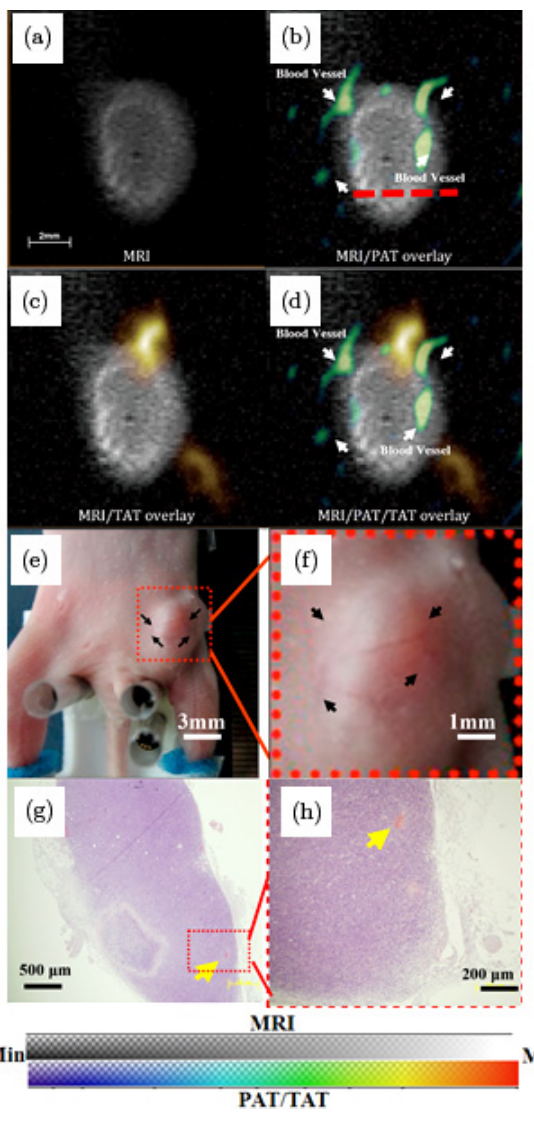
Fig. 4. Combined MR – PA – TA imaging of tumor surface vasculature. For (a) – (d), scale bar ¼ 2 mm. (a) Tumor MRI slice (gray) clearly displayed the tumor morphology informa- tion, while naked eye visible blood vessels indicated by the black arrow in both (e) and (f) disappeared in MRI. Overlay MRI image with 532 nm PAT obtained image (green) and two high PA signals were observed in (b) (as indicated by white arrow). Finger-like protrusions extending into the surrounding tissues were revealed in the MRI/TAT infused image (c), TA signal shown in orange color. (d) displayed co-registered MR – PA – TA image (see Media 2). The scanned coronal slice is in- dicated by the red dotted block in the photograph of tumor, given in (e), and the magni¯ed picture of the FOV (¯eld of view) is shown in (f). Black arrow in (f) shows that the PAT recovered two high signals. Vascular histology analysis indicted in (g) present some vessels of larger size, about 100 (cid:1) m in di- ameter (yellow arrow). One of these blood vessels was magni- ¯ed in (h). The scale bar for (g) and (h) was 500 (cid:1) m and 200 (cid:1) m,